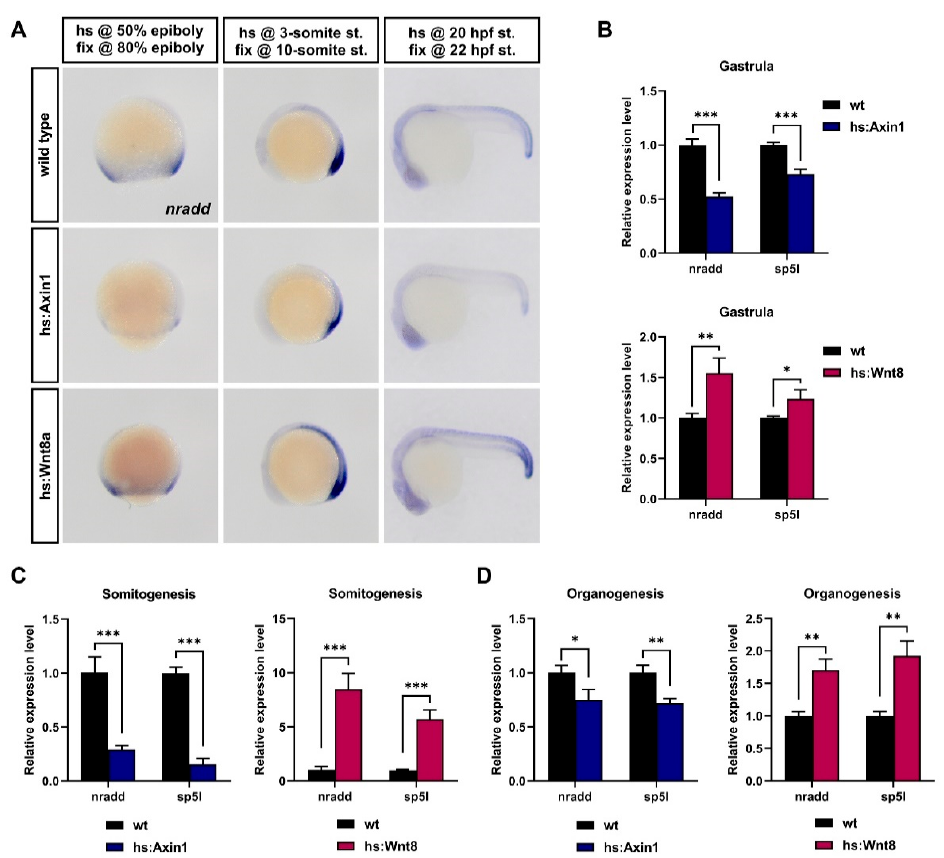
Figure 1. nradd is transcriptionally regulated by Wnt/ β -catenin signaling during development. ( A ) Whole-mount in situ hybridization (WMISH) shows that nradd expression is downregulated in transgenic embryos expressing Axin1 (hs:Axin1) and upregulated in transgenic embryos expressing Wnt8a (hs:Wnt8a) at gastrula (80% epiboly), somitogenesis (10-somite) and organogenesis (22 hpf) stages. (n (80% epiboly): wild type 21/21 embryos, hs:Axin1 18/20 embryos, hs:Wnt8a 16/17; n (10-somite st.): wild type 24/24 embryos, hs:Axin1 24/24 embryos, hs:Wnt8a 28/30; n (22 hpf st.): wild type 19/19 embryos, hs:Axin1 23/25 embryos, hs:Wnt8a 19/20) hs: heat shock, fix: fixation, st: stage, hpf: hours post-fertilization. Three independent experiments were conducted. ( B – D ) nradd and sp5l expression levels determined by qPCR in hs:Axin1 and hs:Wnt8a transgenic embryos are shown relative to those in wild-type embryos at ( B ) gastrula, ( C ) somitogenesis and ( D ) organogenesis stages. Statistical significance was evaluated using an unpaired t -test. * p<0.05, ** p<0.01 and *** p<0.001. Error bars represent ± standard deviation (SD, n = 3). Three independent experiments were conducted.